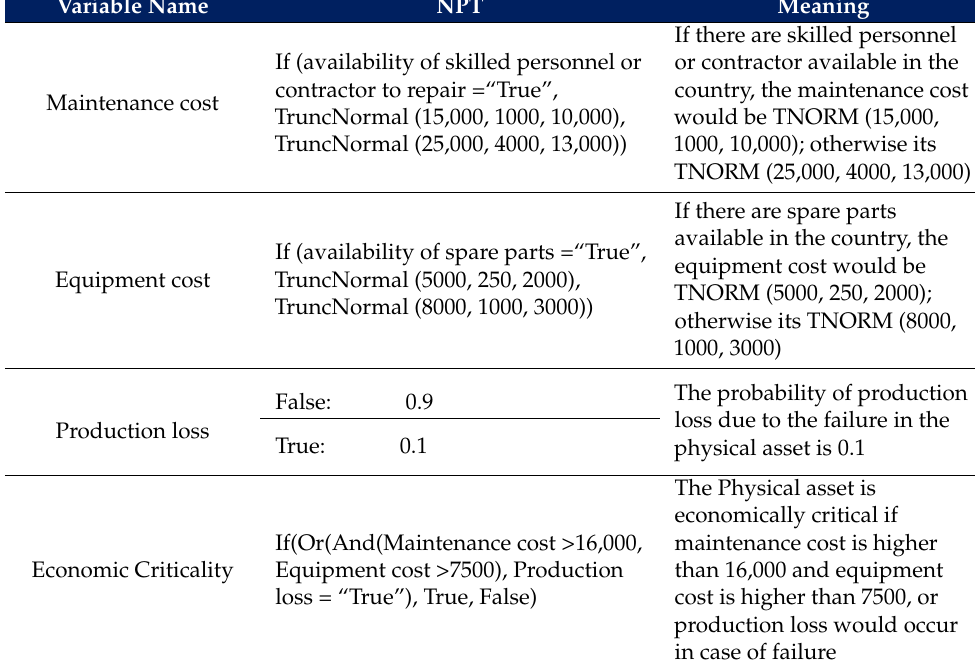
Table 4. NPT of the variables describing the economic factor and economic criticality.